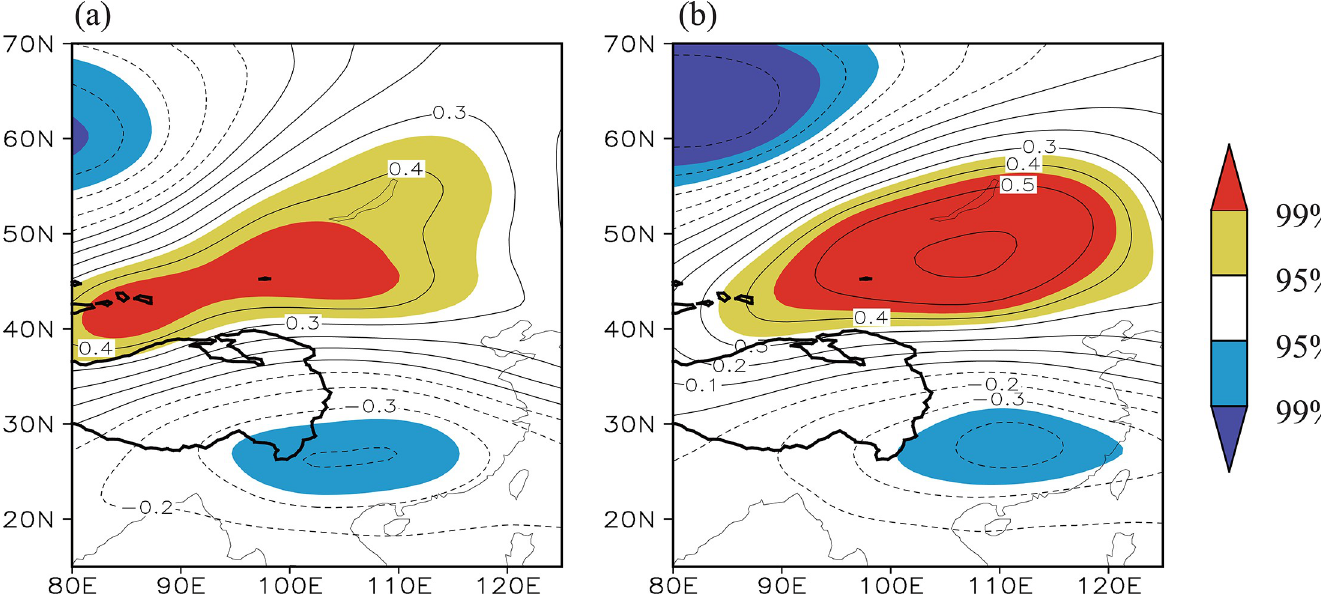
Fig 4. (a) Distribution of the correlation coefficients between the Tibetan Plateau NDVI index and the simultaneous 200 hPa geopotential height field during the time period 1982–2014. (b) Distribution of the correlation coefficients between the Lake Baikal NDVI index and the geopotential height field. The solid contour denotes areas higher than 3000 m altitude. The yellow (red) shading denotes a positive correlation significant at the 95% (99%) confidence level and the blue (purple) shading denotes a negative correlation significant at the 95% (99%) confidence level.